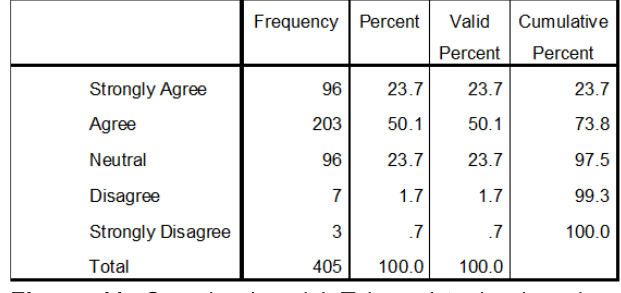
Figure 41. Our cloud and IoT based technology is cost effective and